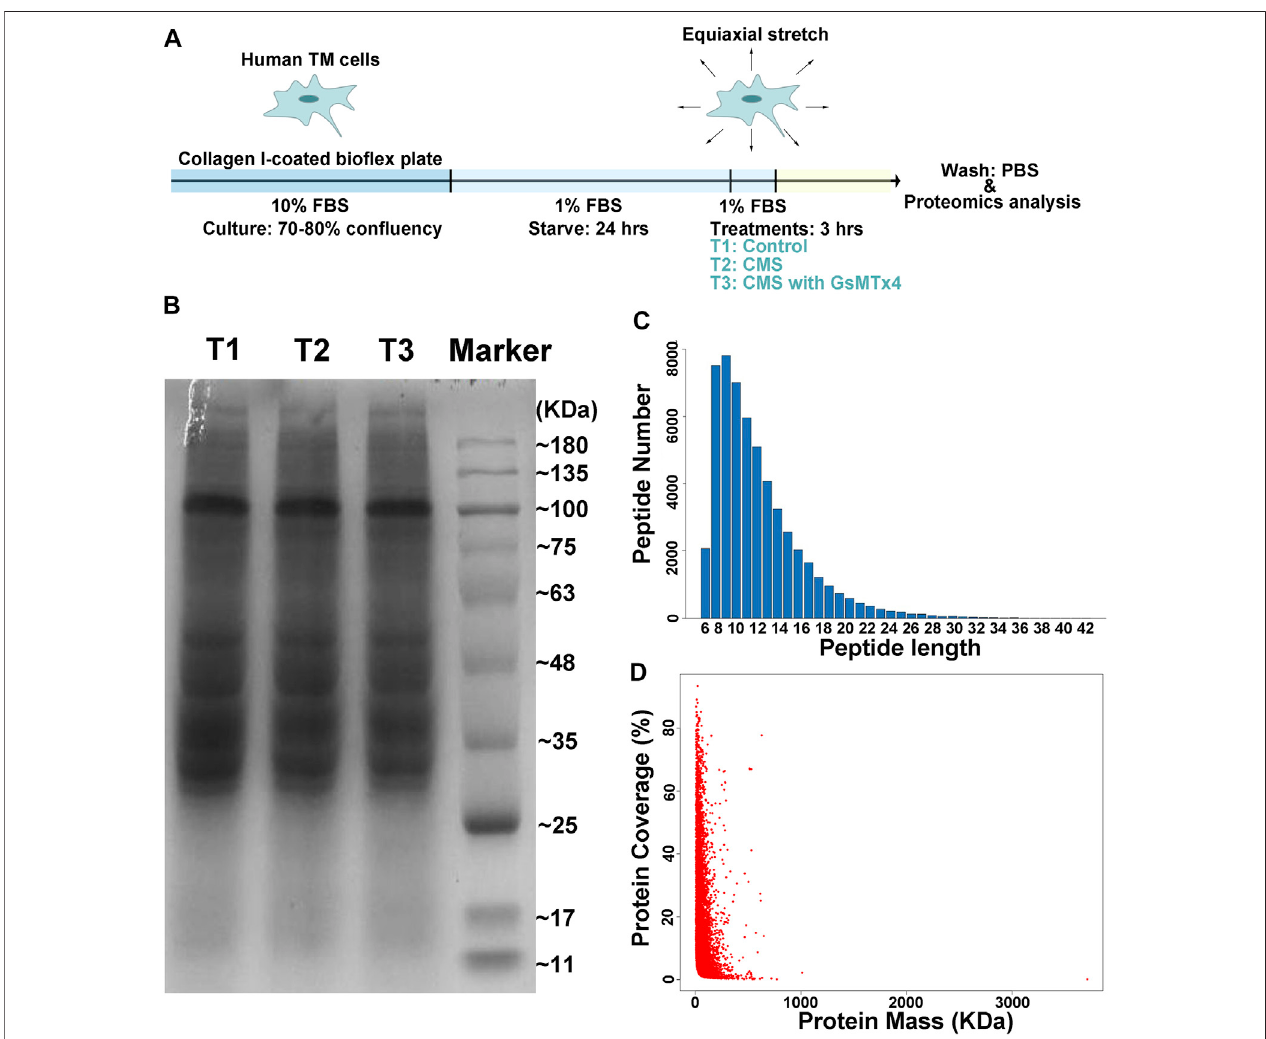
FIGURE1| Schematicillustrationoftheexperimentaldesign. (A) .Schematicdiagramofcellpreparation,cyclicmechanicalstretching,andsamplecollection.HTM cells are seeded onto the collagen I-coated plate, starved for 24 h, stretched cyclically with an amplitude of 20% at 1 Hz for 3 h, and collected for LC-MS/MS analysis, while GsMTx4 (20 μ M) is applied to inhibit the function of CMCs. PBS is used as the vehicle control. T1: Control; T2: Cyclic mechanical stretching (CMS); T3: CMS with GsMTx4. In LC-MS/MS, the quality of our samples (B) , peptides lengths (C) , and protein coverage (D) are shown. Peptides with lengths from 6 to 51 amino acid residues cover over 80% of a